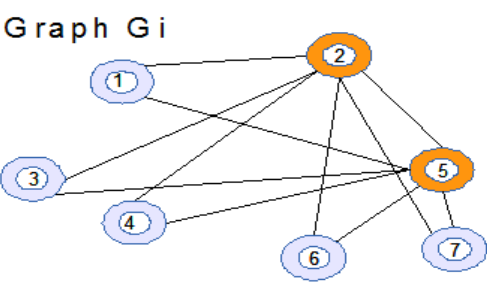
Figure 5. Nodes 2 and 5 are t i -relevant as they have a maximum degree of n = 6 .